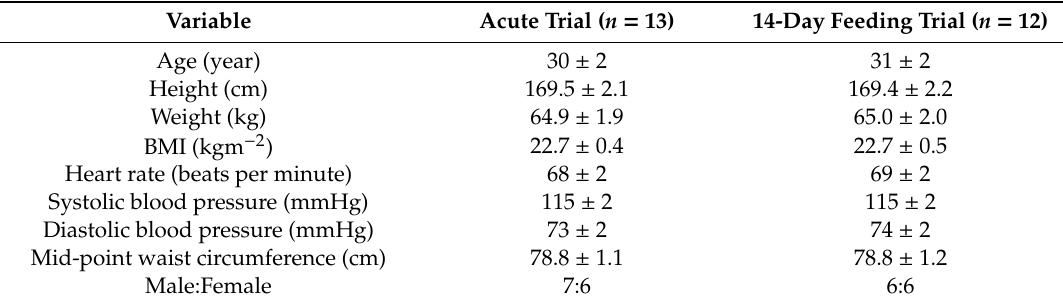
Table 4. Subject demographic characteristics.